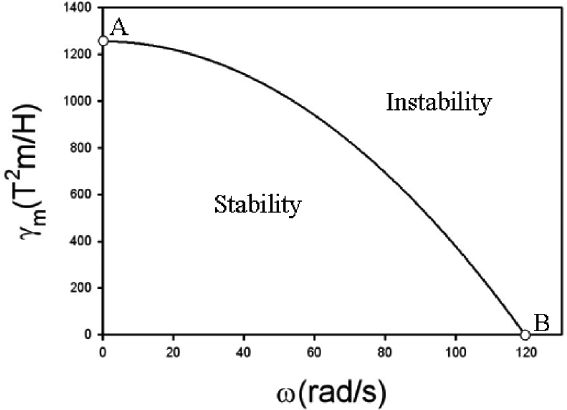
Fig. 3. The stability domain the parameter space of γ m and ω . D = 0.2 m, ρ s = 7800 kg/m 3 , E = 206 GPa, C = 0.0002 m, C e = 0.0002 m, L = 3 m, L b = 0.05 m, x a = 0.08, x b = 0.92, μ o = 0.018 Pa ·